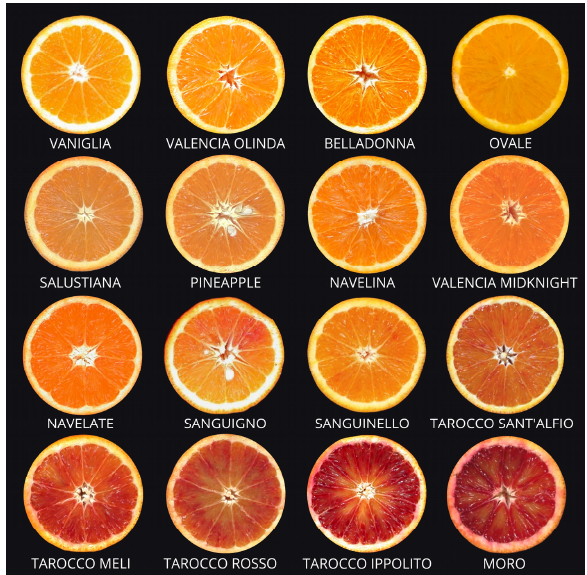
Figure 2. Different types of sweet orange fruits. Agriculture 2023 , 13 , 264